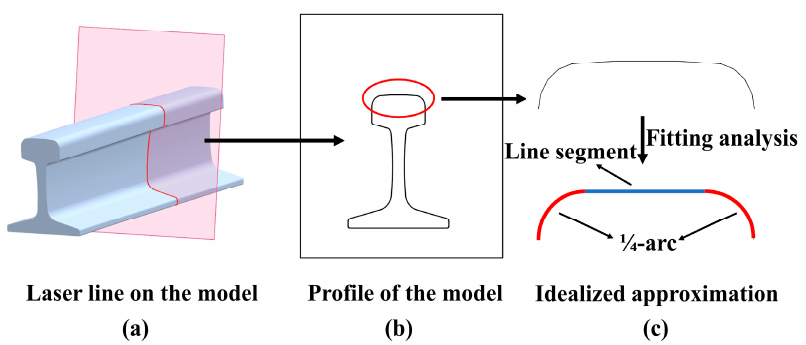
Figure 5. The uniform geometry of the laser profile of the undamaged rail. ( a ) The laser line on the model; ( b ) The single profile acquired from ( a ); ( c ) The idealized approximation of the profile indicated with the red circle in ( b ).